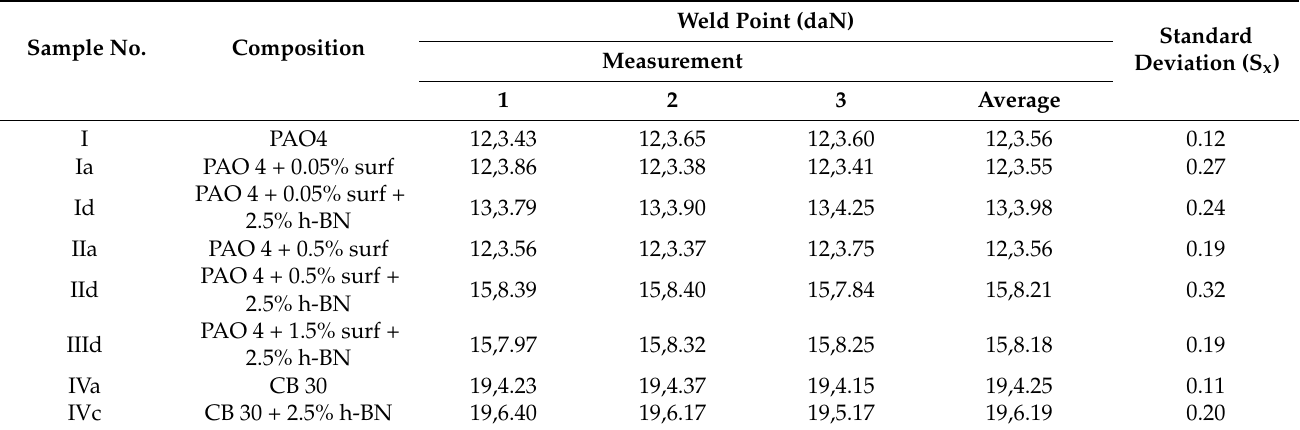
Table 7. Seizure load F t results